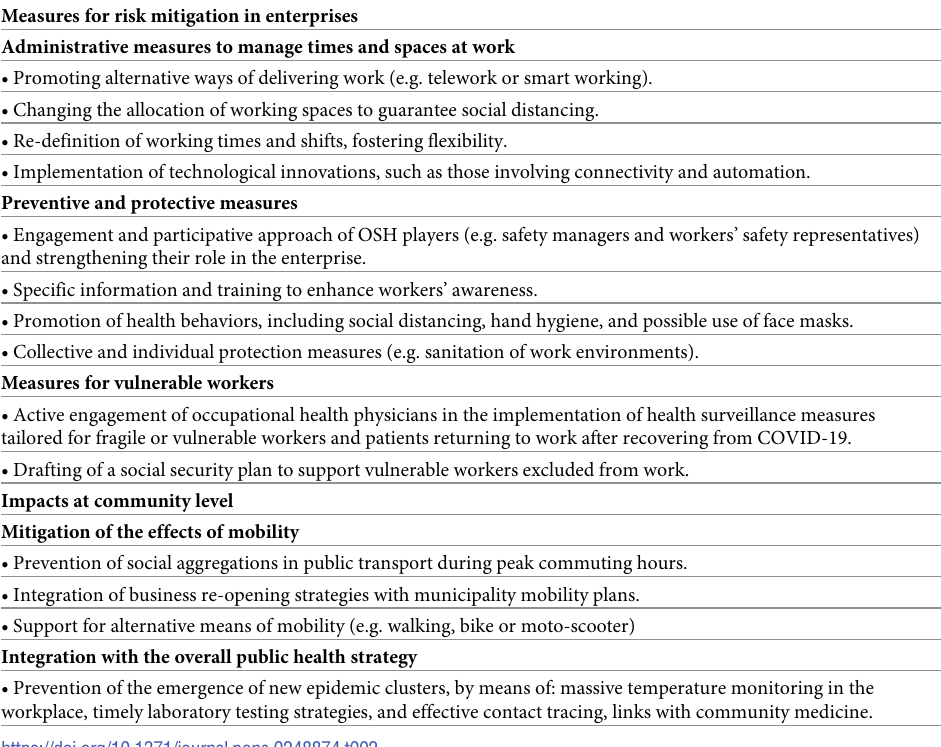
Table 2. Measures for risk mitigation in enterprises and impacts at community